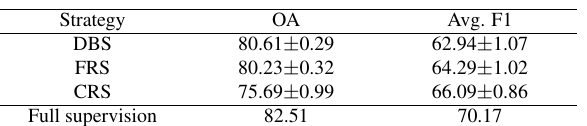
Figure 5. Illustration of classification map on the LASDU dataset. (a), (b), (c), and (d) represent the DBS, FRS, CRS, and ground truth, respectively. Table 5. RF classification results Table 6. KPConv classification